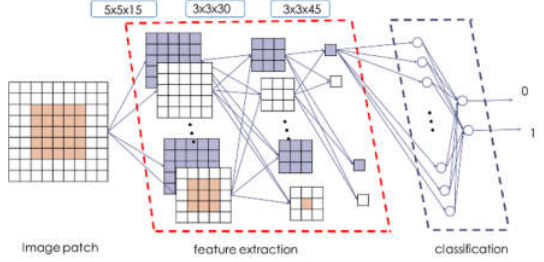
Figure 3. The proposed CNN